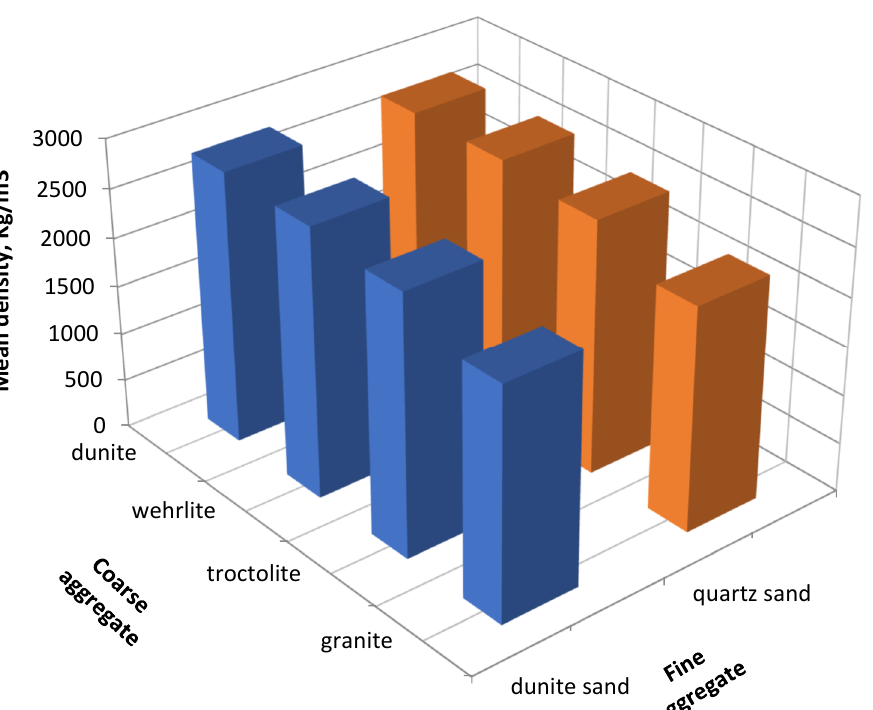
Figure 8. Dependence of the average density of the concrete on the aggregate type.